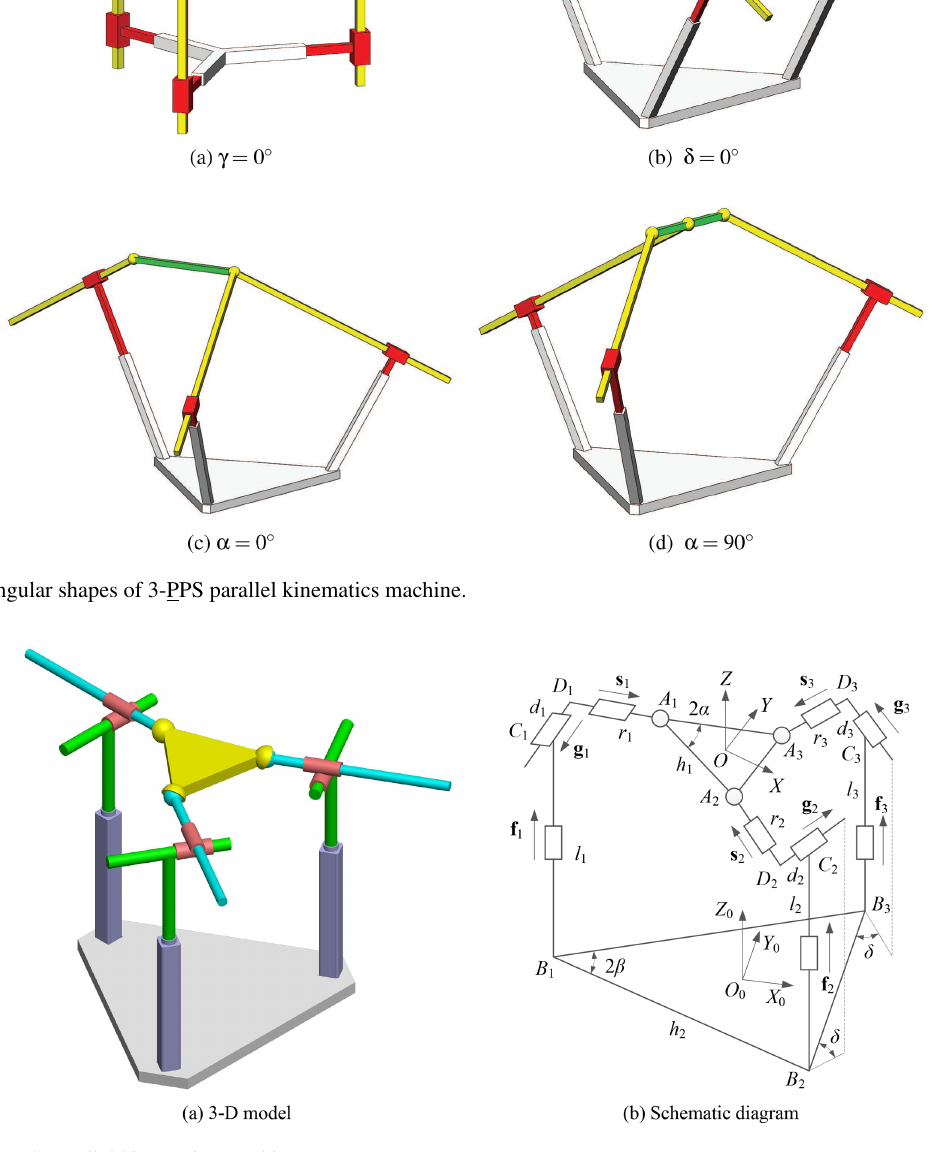
Figure 7. The 3-PPPS parallel kinematics